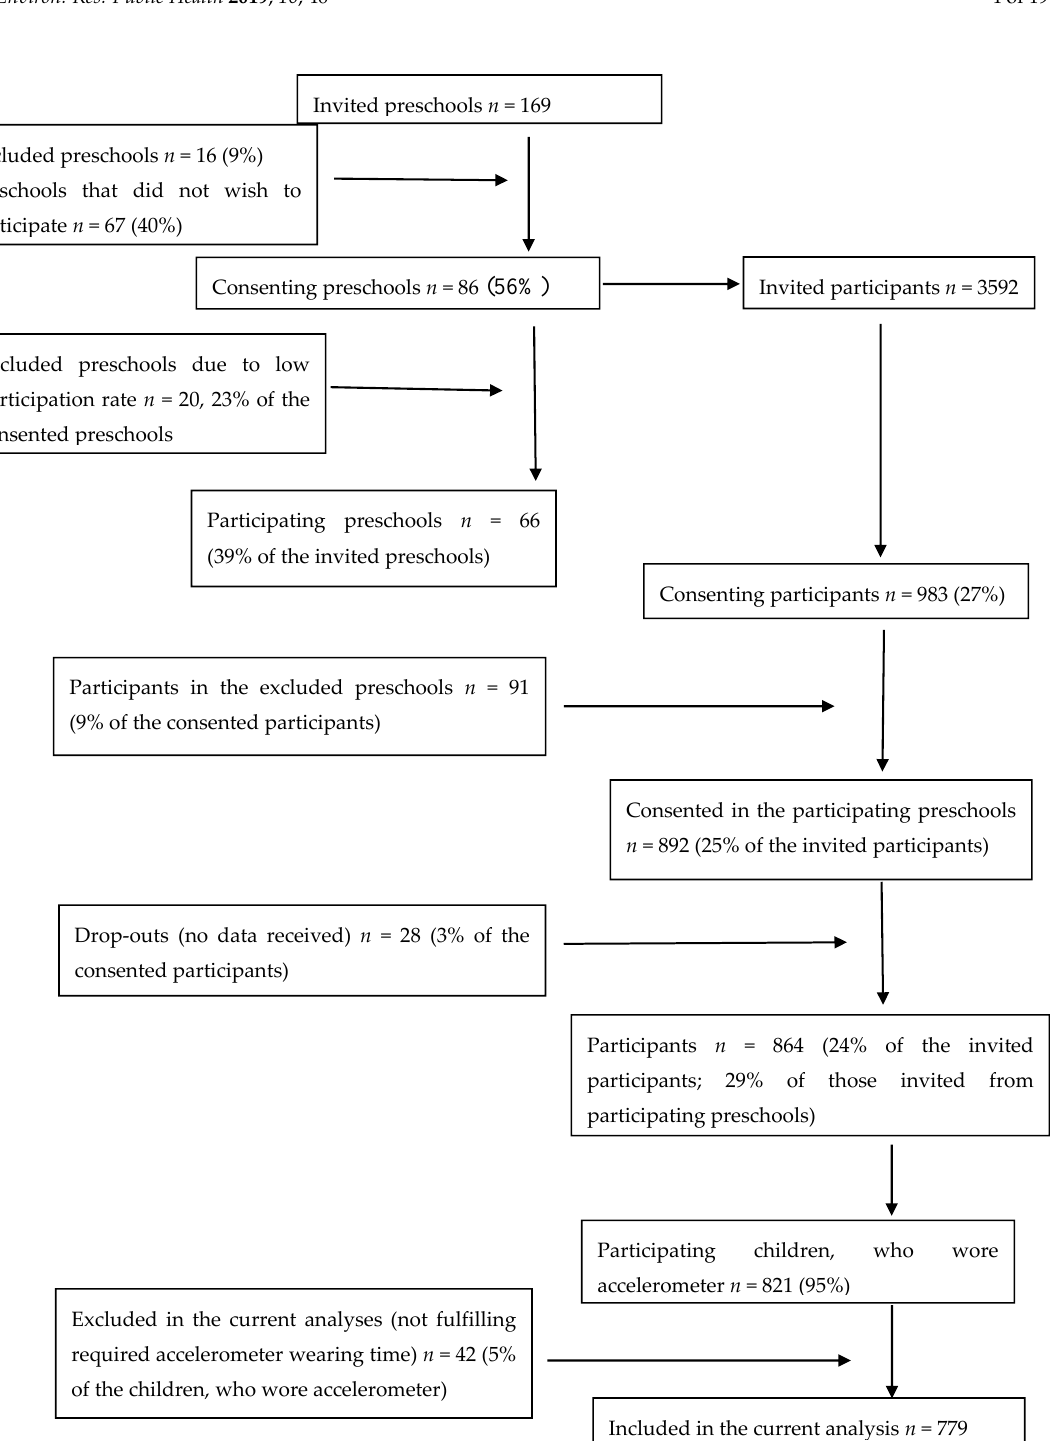
Figure 1. Flowchart of participating preschools and children in the DAGIS (increased health and wellbeing in preschools) cross-sectional